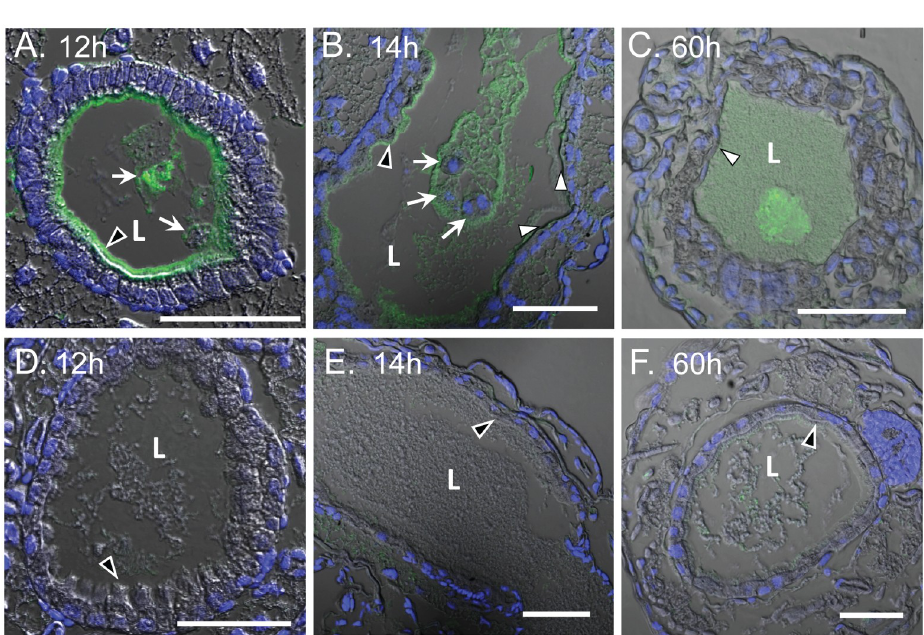
Fig 6. Immunohistochemistry assessment of WCR midgut morphology after feeding with Mpp75Aa1.1. (A) Cross-section of WCR larvae midgut immuno-detected with anti-Mpp75Aa1.1 antibody (green) and stained with the nucleus staining dye, DAPI (blue), after 12 h exposure to Mpp75Aa1.1. Mpp75Aa1.1 binding to intact midgut microvilli is designated by a black arrowhead. White arrows show sloughed off epithelial cellular debris in the lumen (L). (B) Longitudinal section after 14 h exposure to Mpp75Aa1.1. White arrowhead indicates complete to near- complete loss of the apical microvilli layer. (C) Cross-section after 60 h exposure to Mpp75Aa1.1. Complete loss of the apical microvilli is shown by white arrowhead. (D), (E), and (F) are corresponding untreated controls where black arrowheads designate intact apical microvilli layer. Scale bars are all 50 μ m.